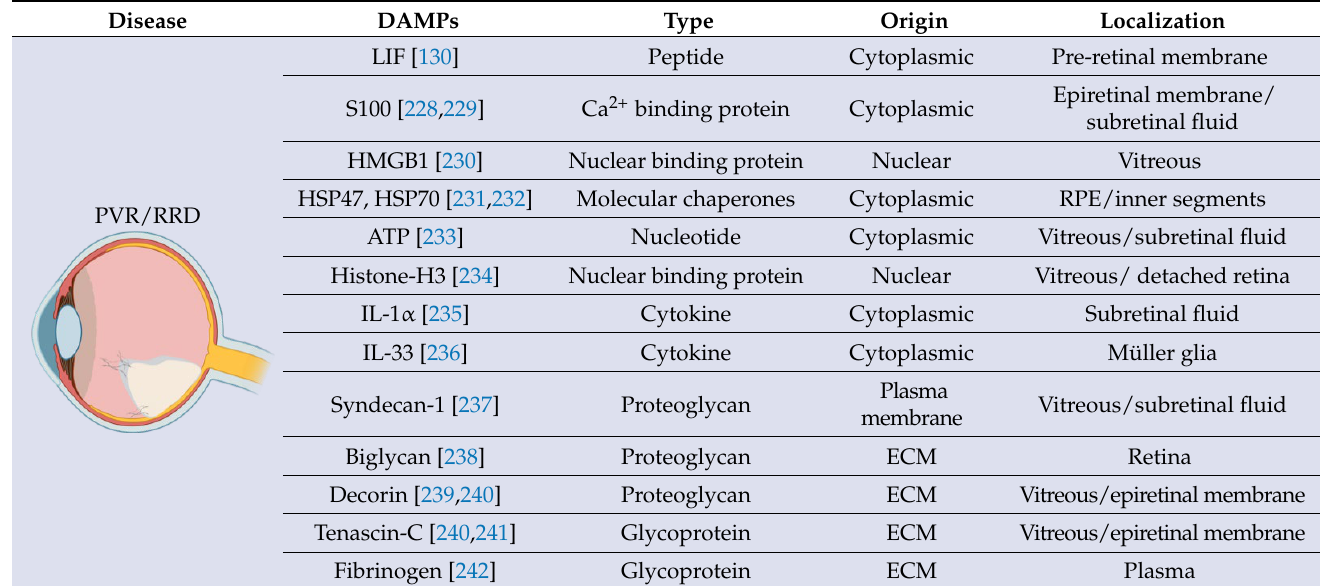
Table 8. DAMPs in proliferative vitreoretinopathy and rhegmatogenous retinal detachment.